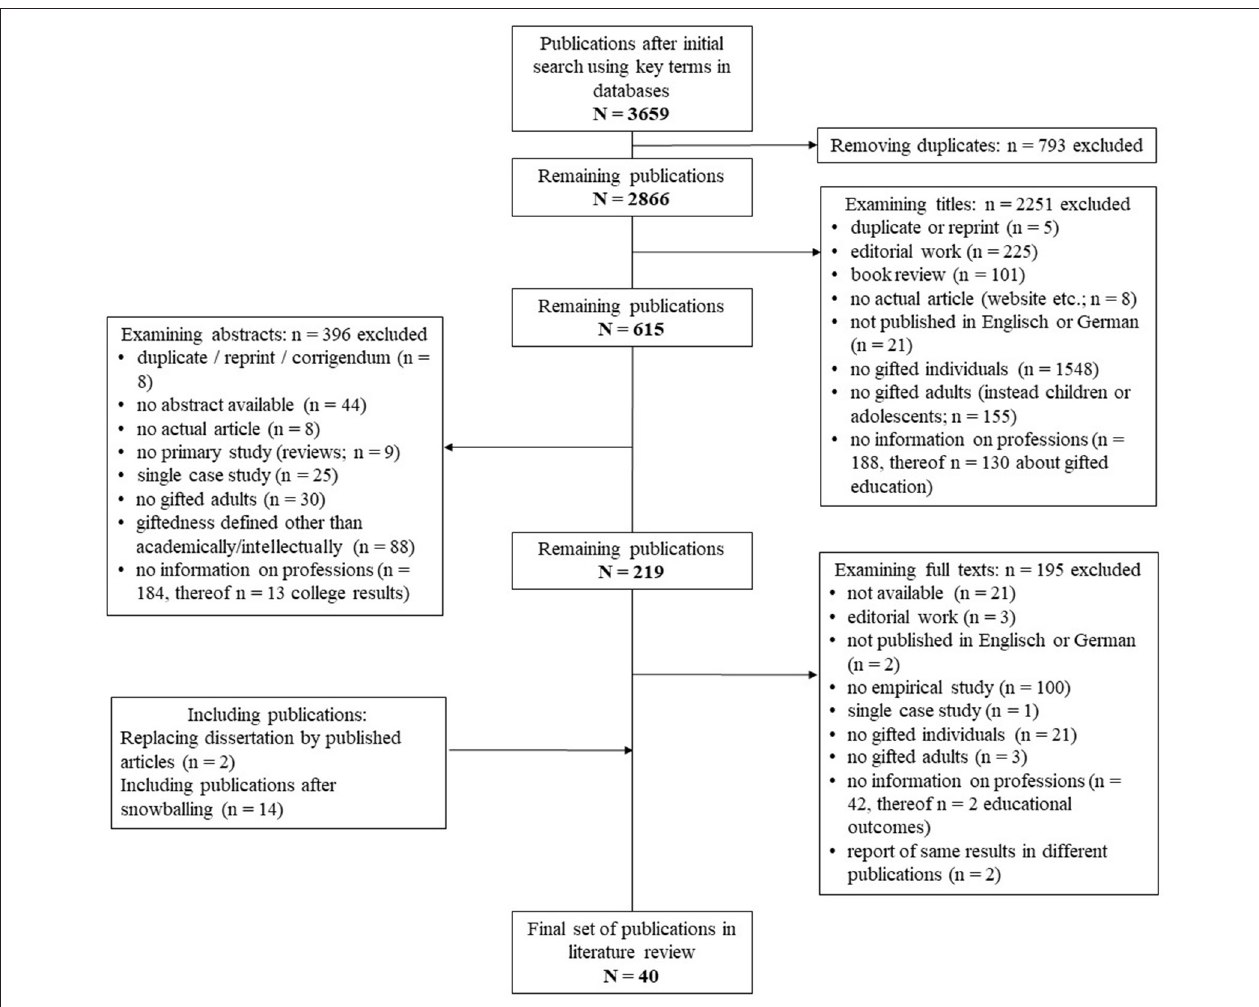
FIGURE 1 | PRISMA flow diagram of the publication selection